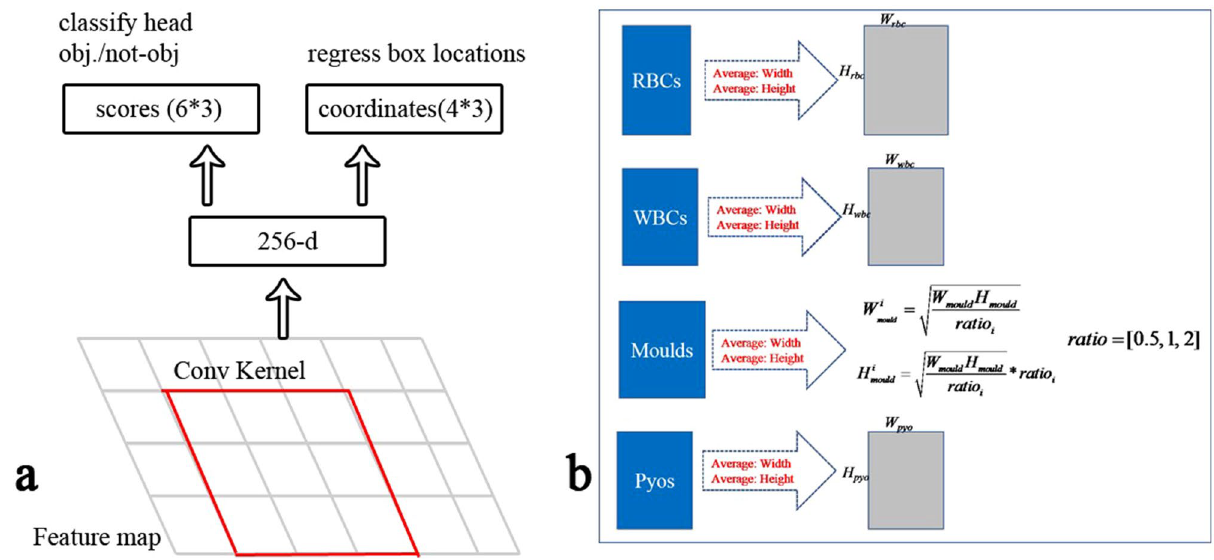
Figure 3. ( a ) Architecture of RPN; ( b ) Generation of anchors. Drawn by DXH.